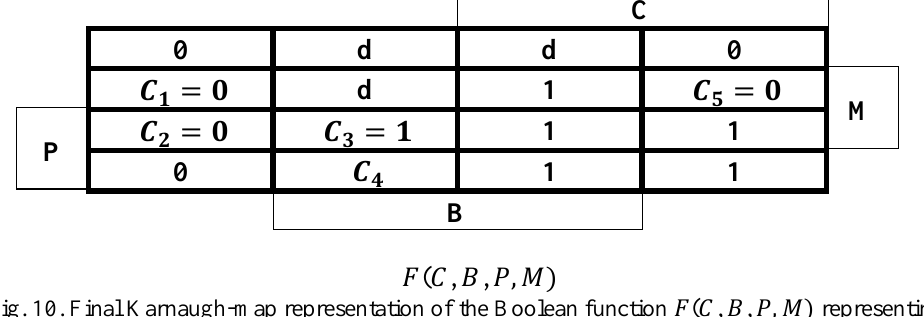
Fig. 10. Final Karnaugh-map representation of the Boolean function 𝐹 ( 𝐶 , 𝐵 , 𝑃, 𝑀) representing an approximate gold standard with three don’t cares and a single unresolved contradiction